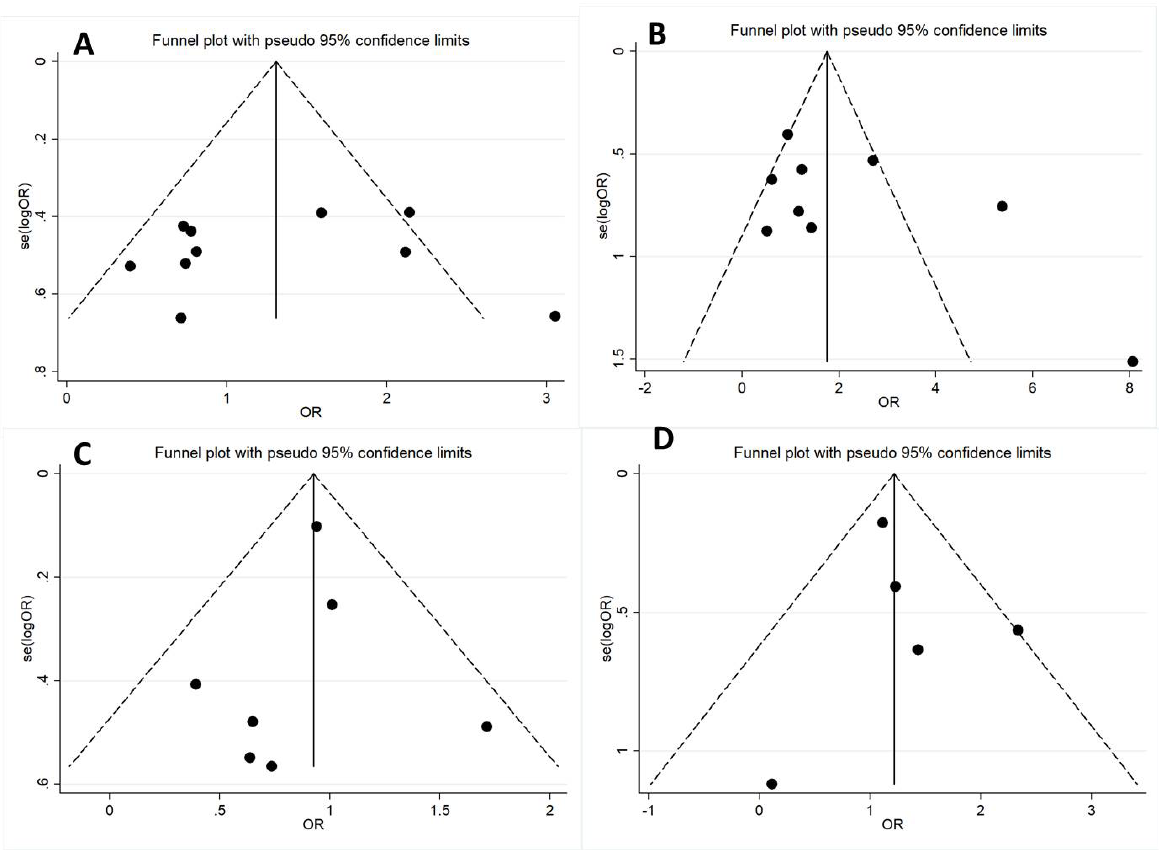
Figure 6: The funnel plot for publication bias